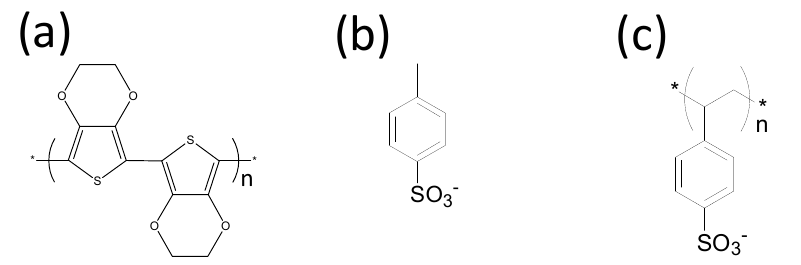
Figure 1. Molecular structures of ( a ) poly(3,4-ethylenedioxythiophene) (PEDOT), ( b ) tosylate (tos), and ( c ) poly(styrenesulfonate)